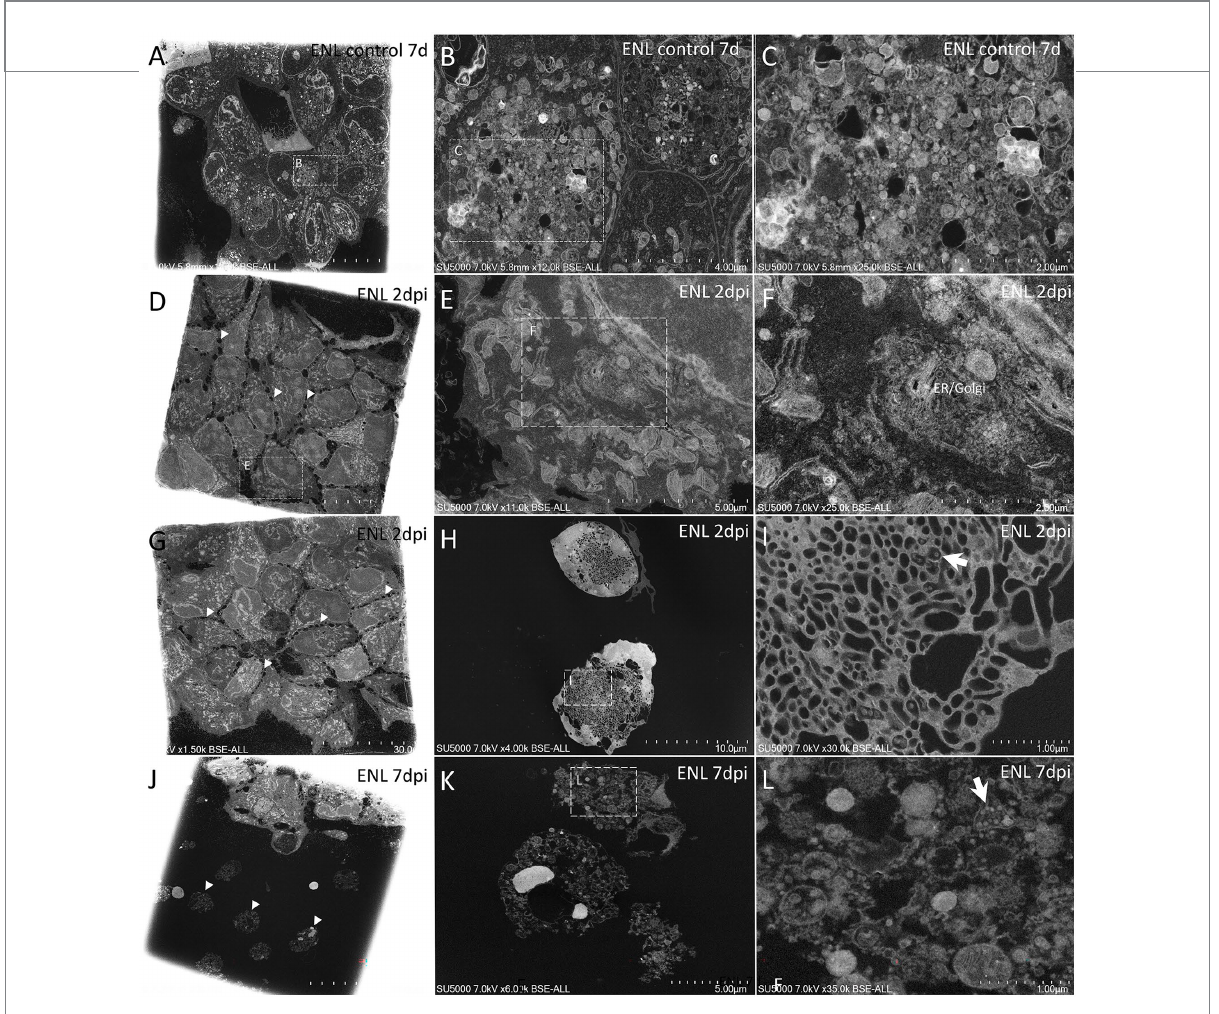
FIGURE 4 Scanning electron microscopy of SARS-CoV-2-infected ENL-R cell monolayer ultra-thin sections. (A) Low-magnification view of control, 7 days noninfected ENL-R cell monolayer; Cells are tightly attached to each other. (B) Zoom-in boxed region in (A) depicting large pockets of material inside control cells. (C) Material from boxed region in (B) with electron-dense or empty objects, with diameters generally below 60 nm and above 140 nm. (D) Low-magnification view of ENL-R cell monolayer at 2 d.p.i with SARS-CoV-2. Cells do not adhere to each other by clear membrane apposition but rather by sparse protrusions (arrowheads). (E) Zoom-in boxed cell in (D) . (F) Zoom-in boxed region in (E) with an extended endoplasmic reticulum/Golgi apparatus. (G) Low-magnification view of ENL-R cell monolayer at 2 d.p.i with SARS-CoV-2. Cells do not show clear confluency (arrowheads). (H) Foamy ENL-R cells at 2 d.p.i with SARS-CoV-2, excluded from the monolayer and presenting an extended tubulo- vesicular network. (I) SARS-CoV-2-like particles (arrow) from boxed regions in (H) . (J) Lyzed ENL-R cells at 7 d.p.i with SARS-CoV-2, with hyperdense nuclei (arrowheads). (K) Lyzed ENL-R cells at 7 d.p.i with SARS-CoV-2. (L) Zoom-in boxed region in (K) with cellular debris and SARS- CoV-2-like virions